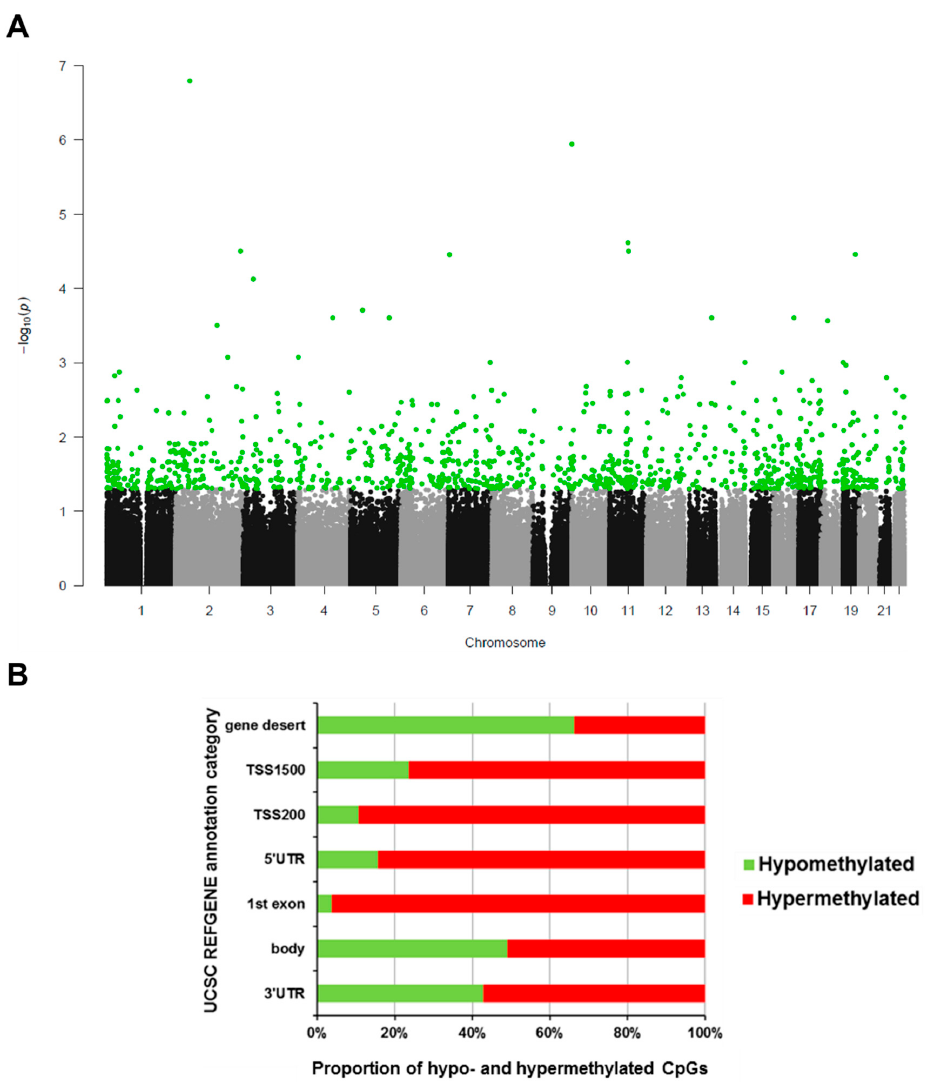
Figure 1. DMPs in EPIC HD. ( A ) Manhattan plot of genome-wide Benjamini Hochberg-corrected p -value distribution of 450K CpG methylation difference in EPIC samples. p -values of differential methylation in 63 pre-diagnostic lung cancer case versus healthy control blood sample pairs are plotted. Green dots indicate 1106 statistically significant probes below the BH corrected p -value threshold of 0.05. ( B ) Relative proportions of hypo- and hypermethylated CpGs by genomic context from the 1106 statistically significantly differentially methylated CpGs in EPIC HD. Annotation categories: gene deserts (none), up to 1500 bp (TSS 1500) or up to 200 bp (TSS 200) upstream of a transcription start site, 5 (cid:48) untranslated region of a gene (5 (cid:48) UTR), first exon (1st exon), gene body (body) or the 3 (cid:48) untranslated region (3 (cid:48)